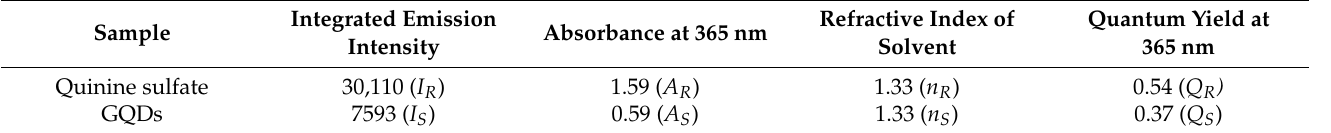
Figure 3. ( a ) FT-IR spectra, ( b ) Raman spectra, and ( c ) broad range XPS spectra of GQDs, the inset: the deconvoluted C 1s and N 1s. Table 1. Quantum yield of